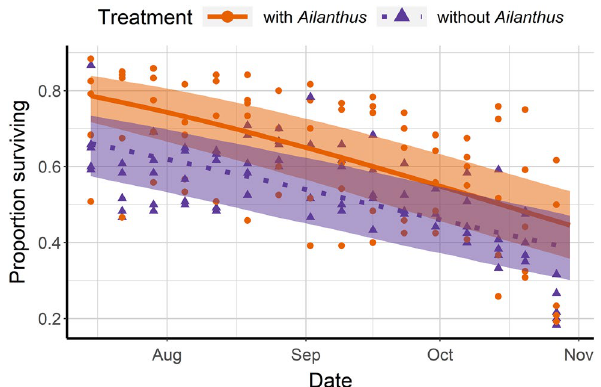
Figure 2. Proportion of Lycorma delicatula (nymphs and adults combined) that survived in enclosures with planted Ailanthus altissima , Acer saccharinum , Juglans nigra and Salix babylonica (‘ Ailanthus ,’ n = 5 enclosures) or enclosures with the same tree species except for the presence of Betula nigra in place of A. altissima (‘without Ailanthus ,’ n = 5 enclosures) from July 15 to November 4, 2020. Fitted binomial regression lines are shown, with shaded areas indicating 95% confidence intervals for predicted regression means. In total, 120 third-instar nymphs were released in each enclosure and their numbers and host tree associations were recorded weekly.